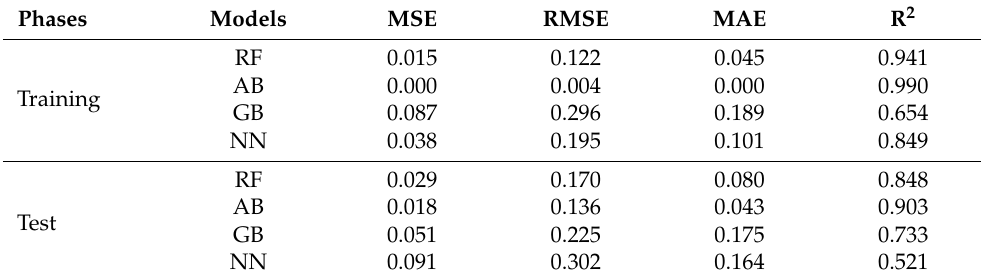
Table 4. Performance measurement values of testing and training phases.